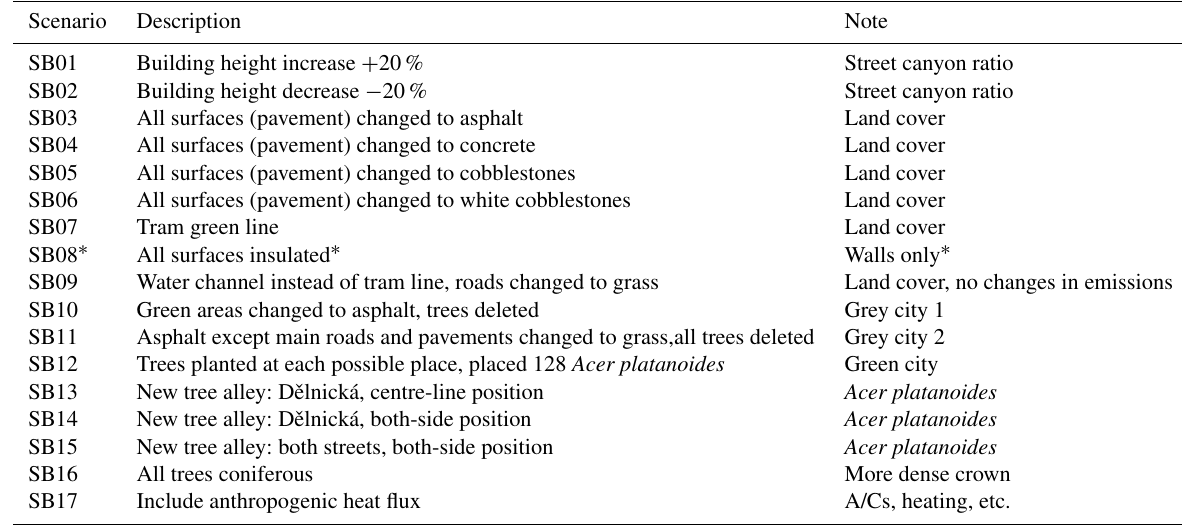
Table 2. Scenarios testing sensitivity of the model results to UHI mitigation